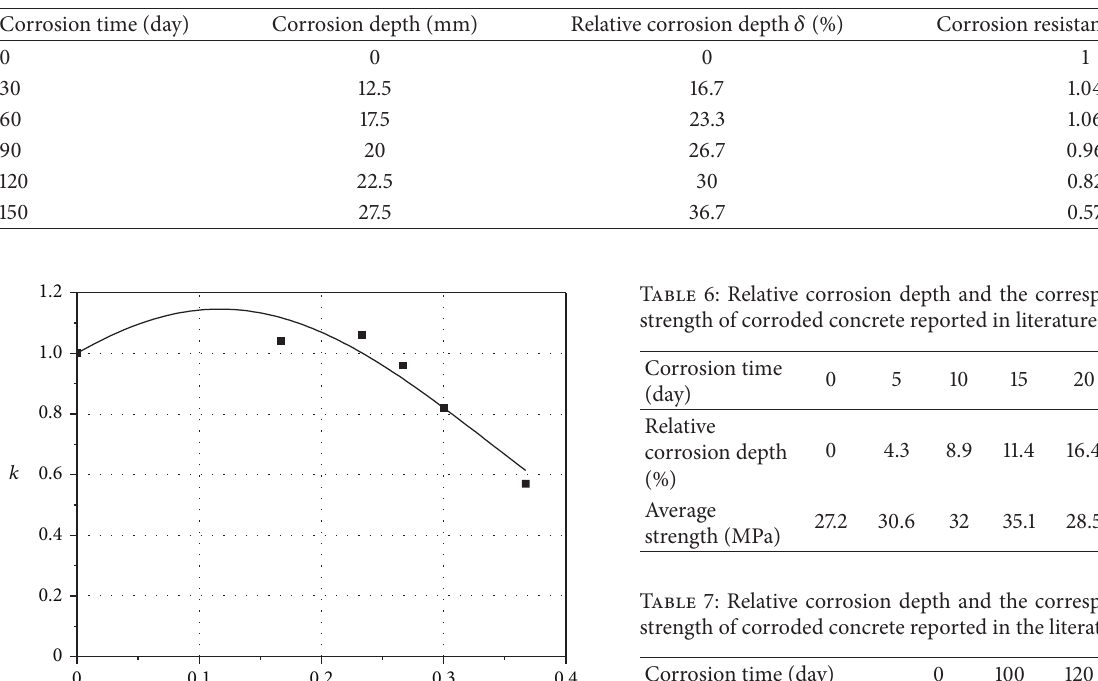
Table 5: Corrosion resistance coefficient and relative corrosion depth.